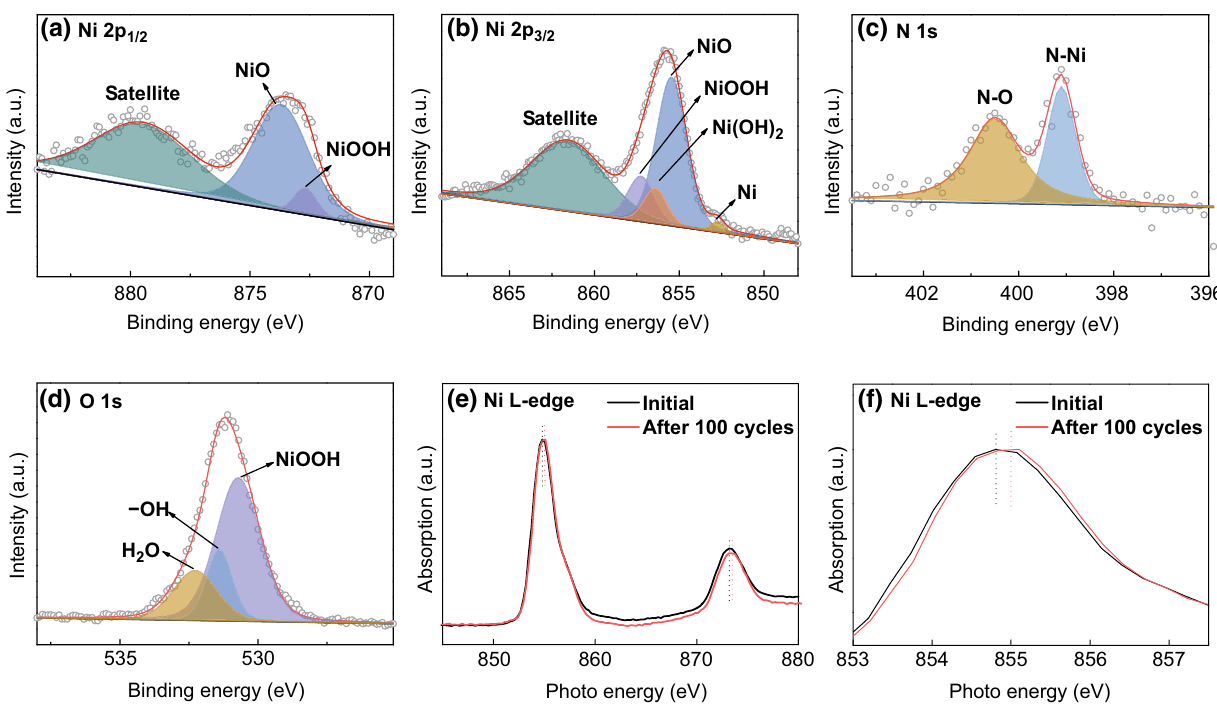
Fig. 5 XPS spectra of N-SN after 100 cycles. a Ni 2p 1/2 , b Ni 2p 3/2 , c N 1s, d O 1s. e – f NEXAFS spectra of N-SN before and after 100 OER